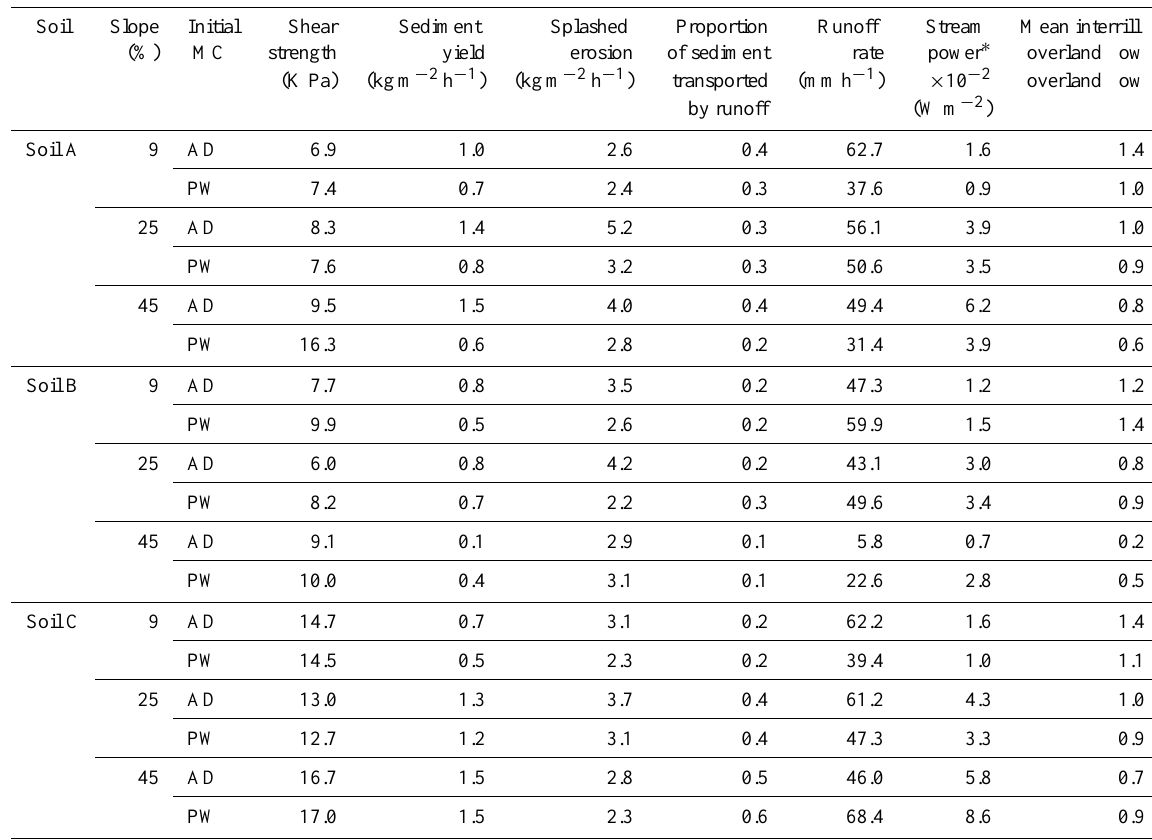
Table 4. Shear strength (Resistance), sediment yield, splash detachment and runoff rate values for each combination of soil type, slope steepness, and initial moisture